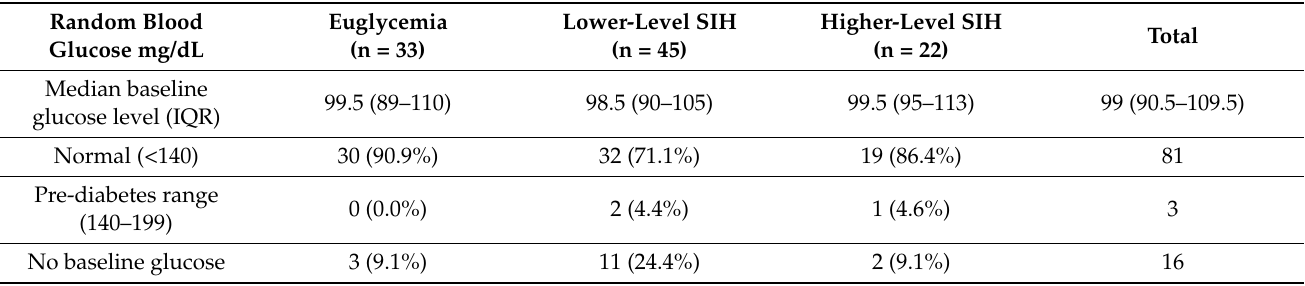
Table 2. Number of patients with baseline blood glucose levels observed in euglycemia, lower-level SIH, and higher-level